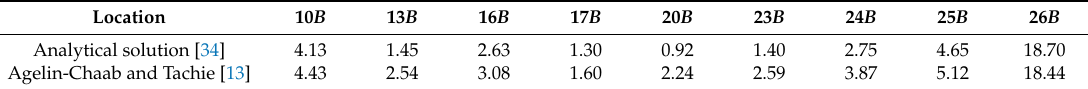
Table 2. MARE (%) values for U profiles in x - y plane at different locations ( y / y m/2 < 1.5). Location